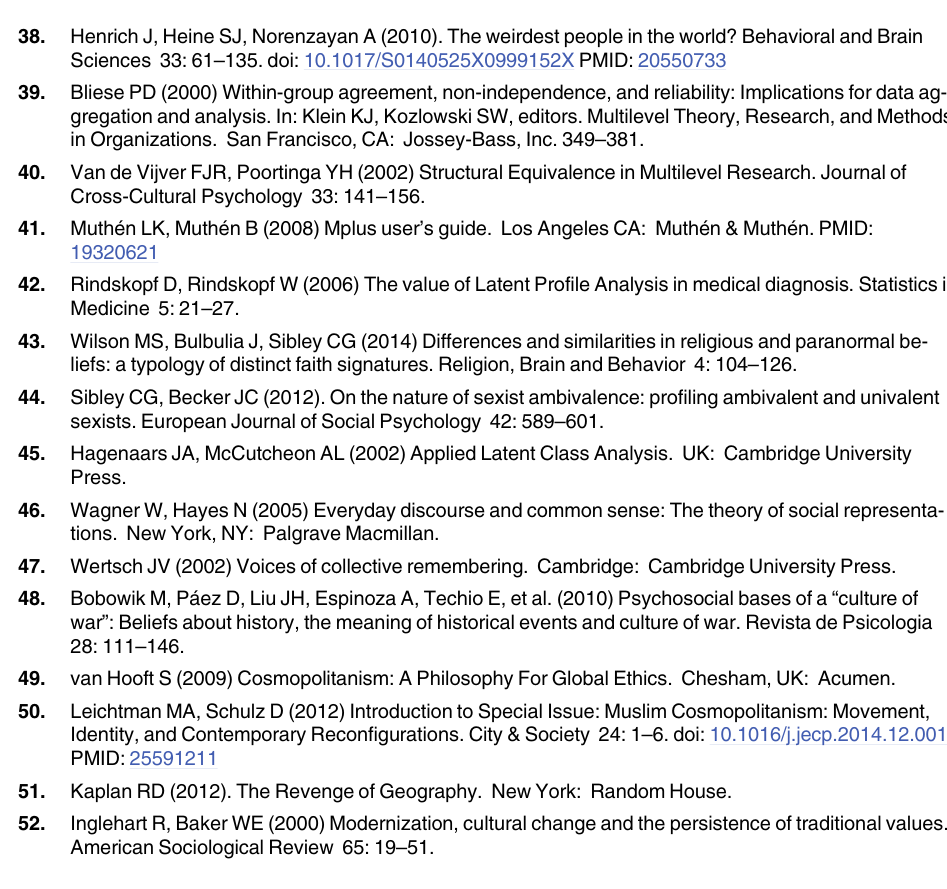
PLOS ONE | DOI:10.1371/journal.pone.0115641 February 4,